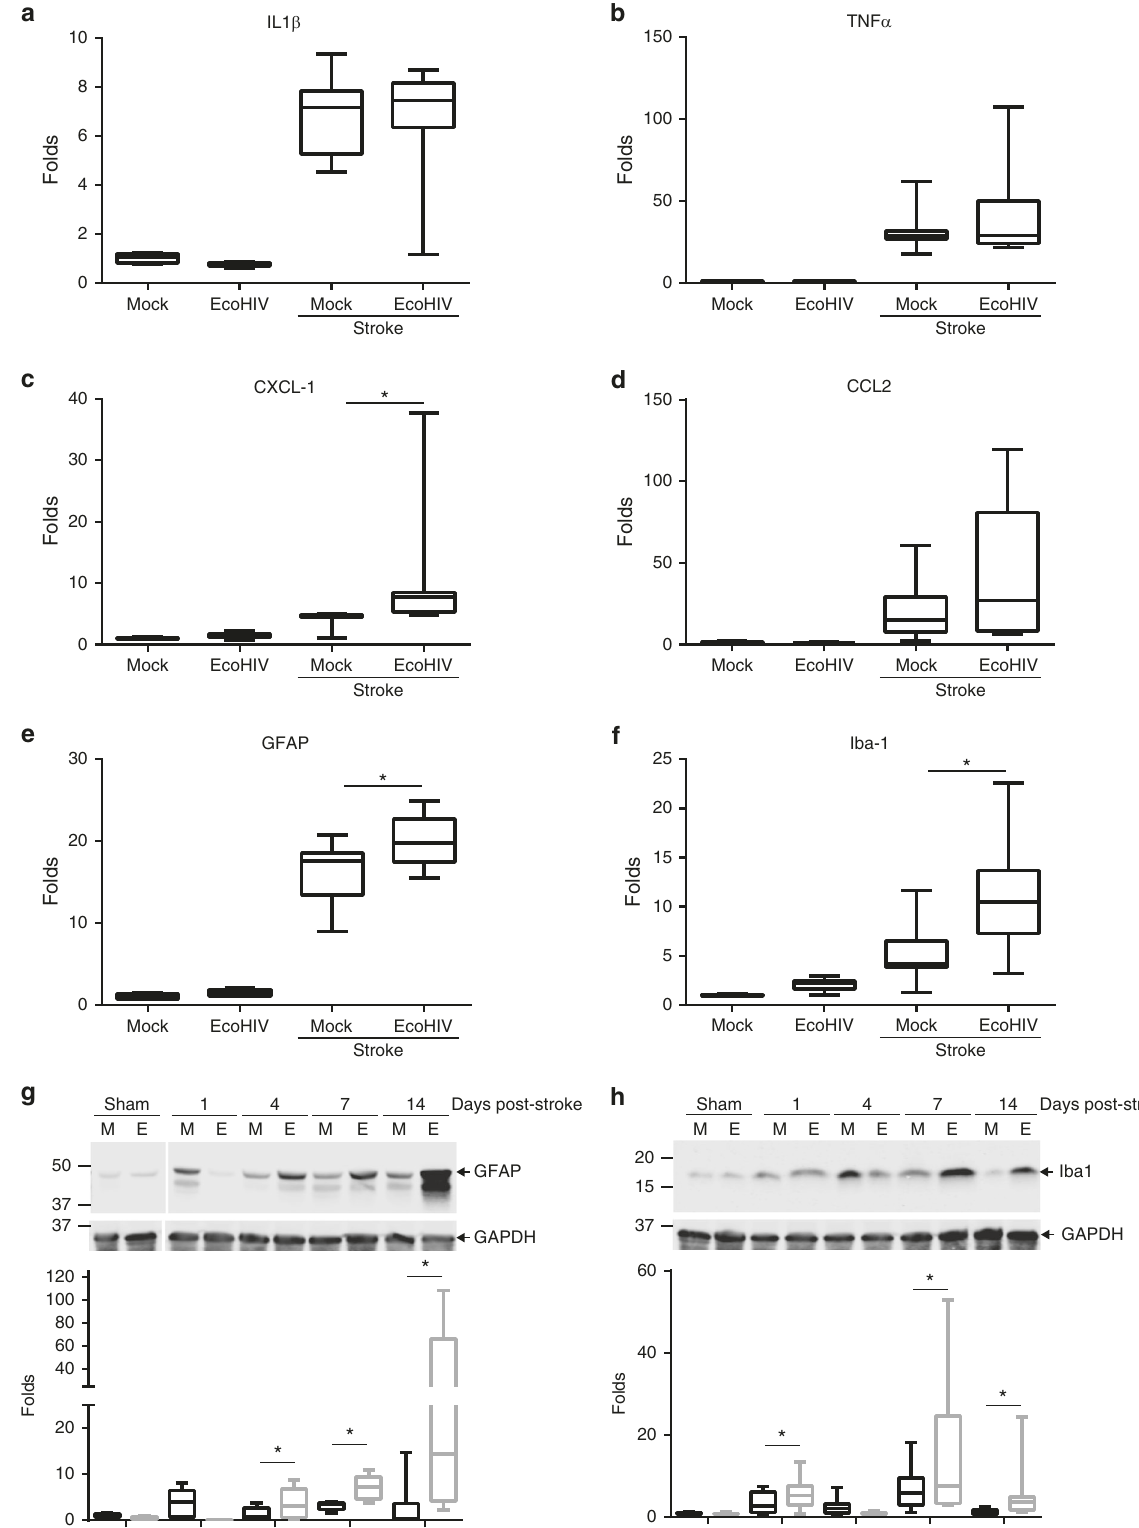
Fig. 4 Prolonged post-ischemic stroke in fl ammation in EcoHIV-infected brains. Mice were infected with EcoHIV and subjected to stroke as in Fig. 1. mRNA expression of cytokines IL1 β ( a ) and TNF α ( b ) chemokines CXCL1 ( c ) and CCL2 ( d ), and cellular activation markers GFAP ( e ) and Iba1 ( f ) were assessed by real-time qPCR 7 days post stroke. Sham, n = 6; Stroke, n = 12 mice per group, 3 independent experiments. Time course of GFAP ( g ) and Iba1 ( h ) protein expression levels as quanti fi ed by western blotting in sham and ischemic stroke animals at days 1, 4, 7, and 14 post-stroke in mock (M) and EcoHIV- infected (E) mice. Representative blots are shown, and quanti fi ed results are illustrated on the bar graphs. n = 5 – 12 mice per group, 3 independent experiments. Whiskers-box plots represent centerline median, with interquartile range and min-max whiskers. Source data are provided as a Source Data fi le. * p < 0.05; one-way ANOVA, followed by Tukey multiple comparison test ( a – f ) and unpaired t test ( g , h